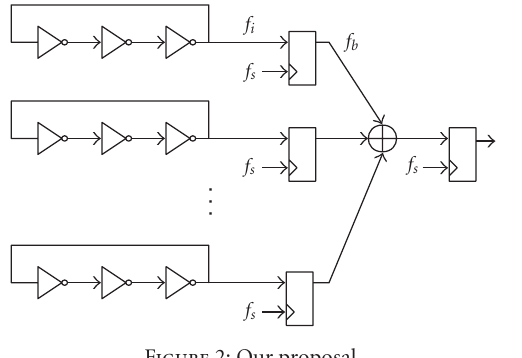
Figure 2: Our proposal.